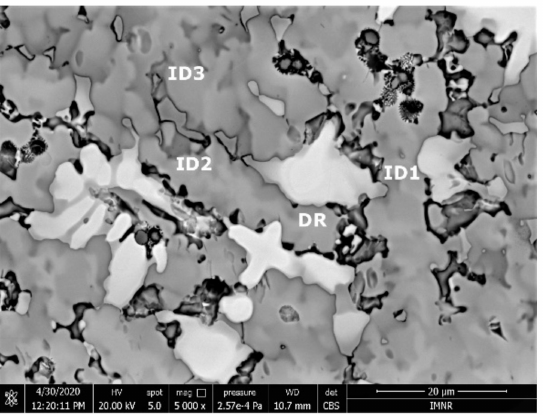
Figure 15. SEM-EDS images for the as-cast FeTa 0.5 Nb 0.5 TiZr 0.5 alloy sample with the selected points for EDS analysis.